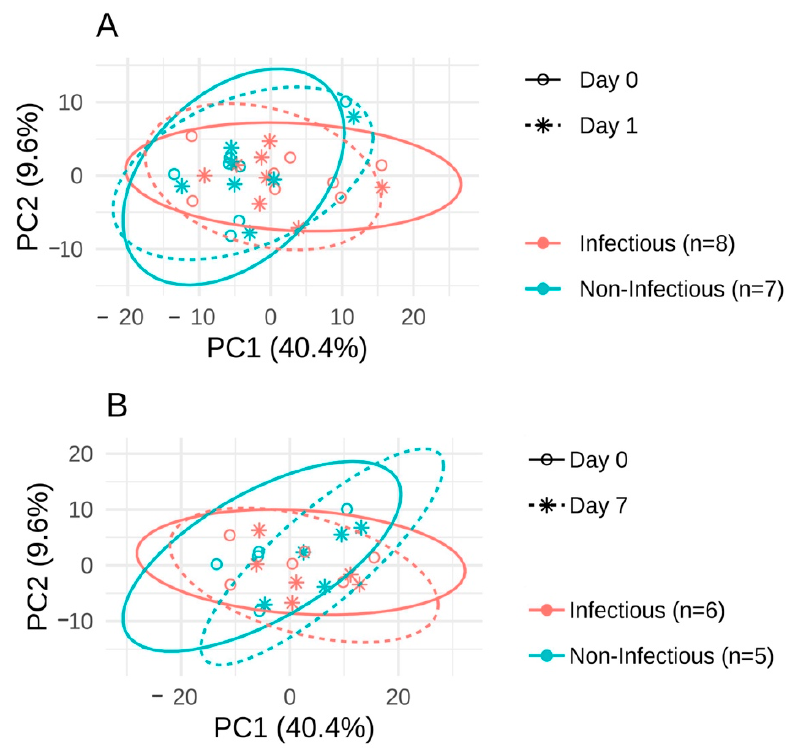
Figure 2. The principal component analysis PCA in ILR-coordinates for comparison of changes between: ( A ) the day before the surgery and the 1st day after it; ( B ) the day before the surgery and the